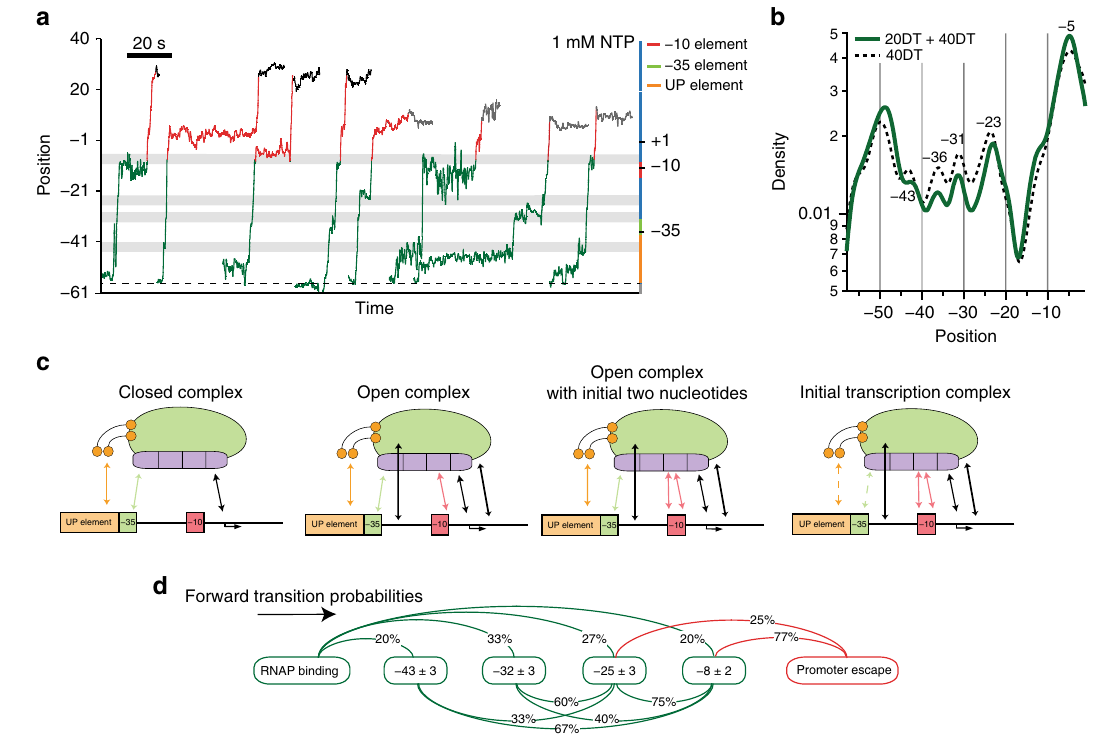
Fig. 4 Real-time transcription initiation records. a Eight representative records showing RNAP holoenzyme initiation. Left axis: holoenzyme position; measured extensions (in nm) were converted to nucleotide positions relative to the TSS. Right axis: non-template strand promoter sequence, using the color scheme of Fig. 2. The starting base of the hairpin stem is indicated (black dashed line, position − 56). The records are color coded with respect to the stages of initiation process: stepwise contact remodeling (green), productive initiation (red), and stalled at the end of the template (40DT template, black; 20DT template, gray). Gray bars indicate the positions of strong contacts. b Semi-log plots of the mean density of records obtained in the presence of NTPs on the 40DT template ( N = 12, black dotted curve), and the 40DT and 20DT templates combined ( N = 16, green curve). The maxima con fi rm the assignment of contacts (see text). c Summary of the contacts remodeled within the RNAP-promoter complex during transcription initiation. Solid arrows indicate essential contacts; dashed arrows indicate non-essential contacts (arrows are color coded by their respective elements). d Transition probabilities in the forward direction (black arrow, computed percentages exclude reversible transitions between states) from RNAP binding to promoter escape ( N = 44 transitions from 15 molecules, color code same as a ). The states (rounded squares) were identi fi ed based on dwells lasting > 1 s, and